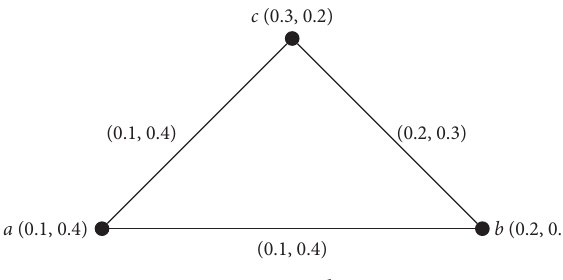
Figure 3: A complete VG G